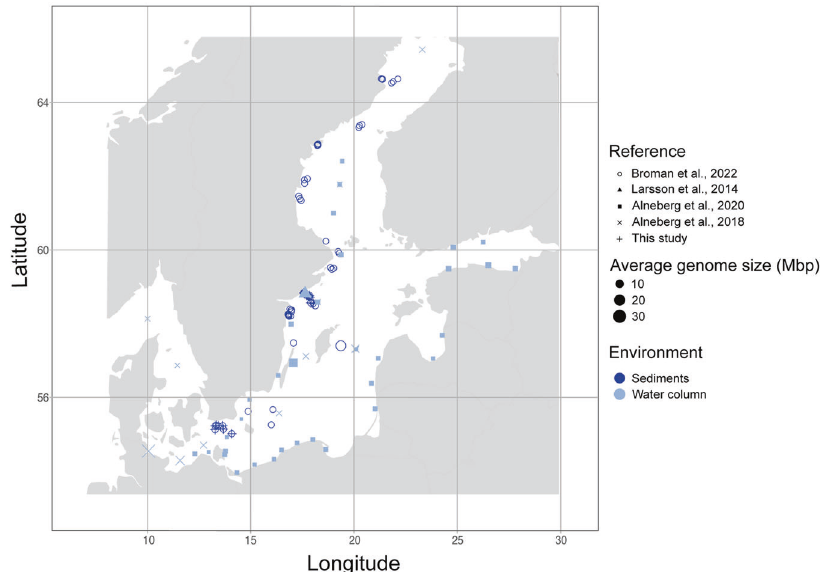
Fig. 1 Overview of the sampling locations and average genome size (AGS) of metagenomes (108 from sediments in dark blue, and 111 from the water column in light blue). This fi gure shows the geographic location of all metagenomes used in this study. For exact coordinates see Table S1. Shape type indicates the reference and shape size indicates the AGS of the given